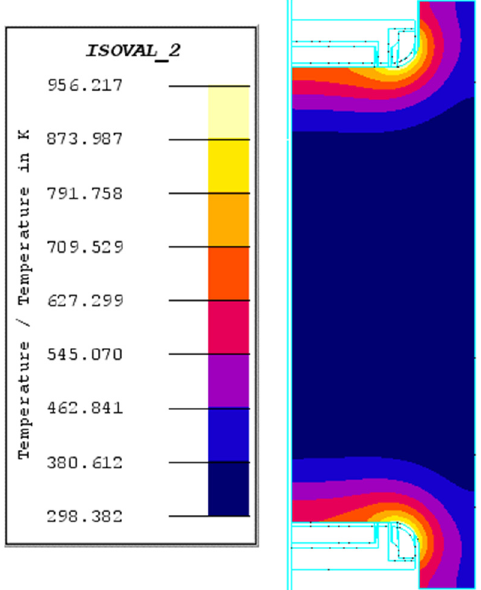
Figure 14. Temperature field of crankshaft N1 during the heating stage (T=6S).